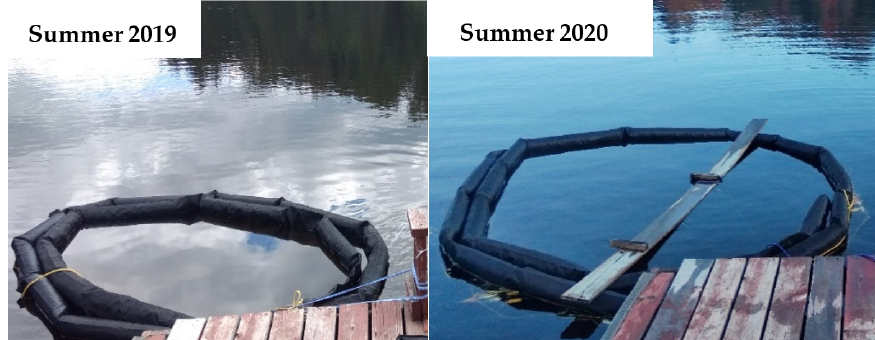
Figure 4. In-situ deployment for the control enclosed area in the two-summer experiment. Table 1. Non-woven, woven geotextiles and mesh characteristics used in this